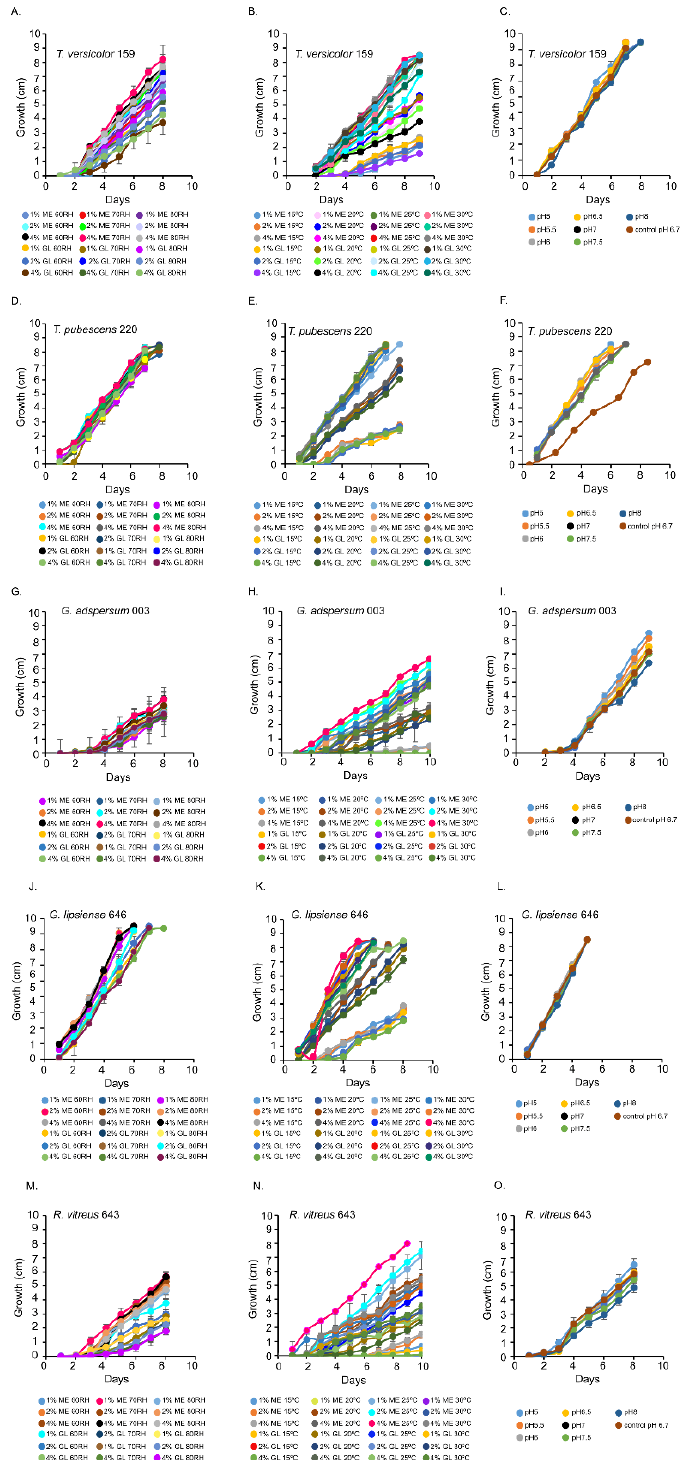
Figure 1. Growth rates of white rot fungi in the presence of different percentages of malt extract (ME) and glucose (GL). ( A , D , G , J , M ) show the growth of fungi at various percent relative humidities (RH). ( B , E , H , K , N ) show the growth of fungi at various temperatures. ( C , F , I , L , O ) show the growth of fungi at various pHs. Data represent an average of ≥ 5 biological